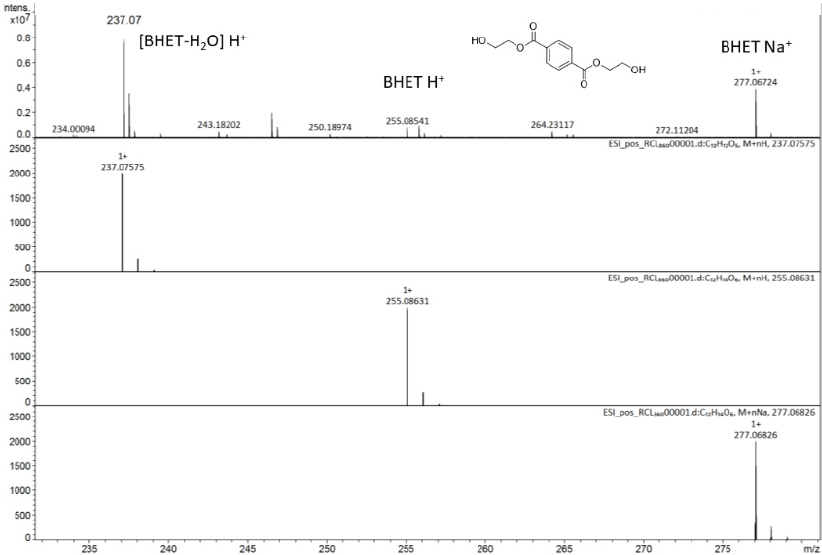
Figure 5. ESI-MS spectra of BHET obtained via crystallization from cold water.